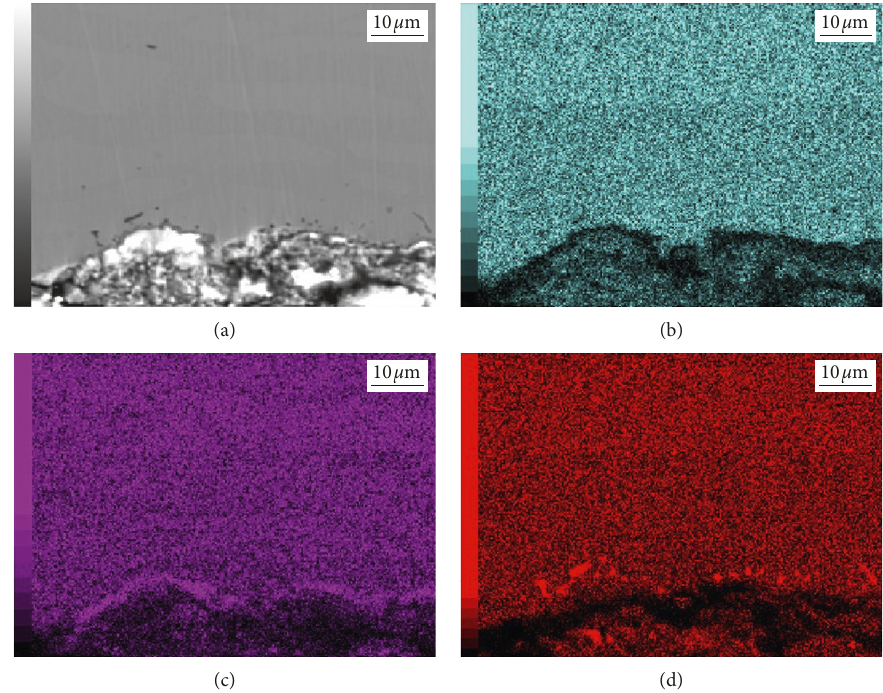
Figure 2: SEM images of the cross-sectional morphology (a) and EDS maps of Fe (b), Cr (c), and Si (d) for oxidized